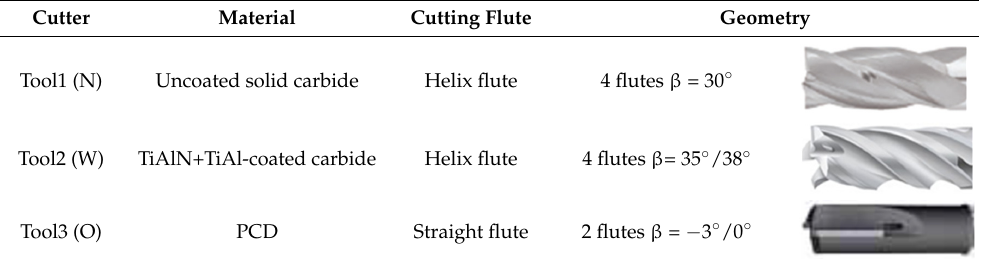
Table 1. Specifications of the cutting tools.